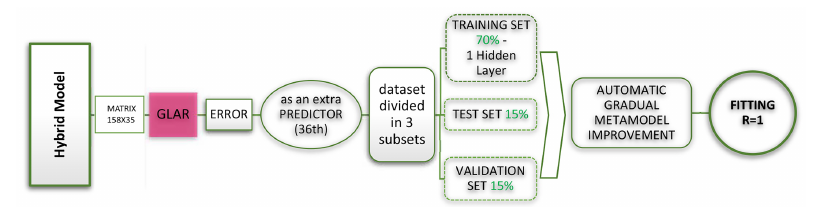
Fig. 3. Metamodel neural network’s